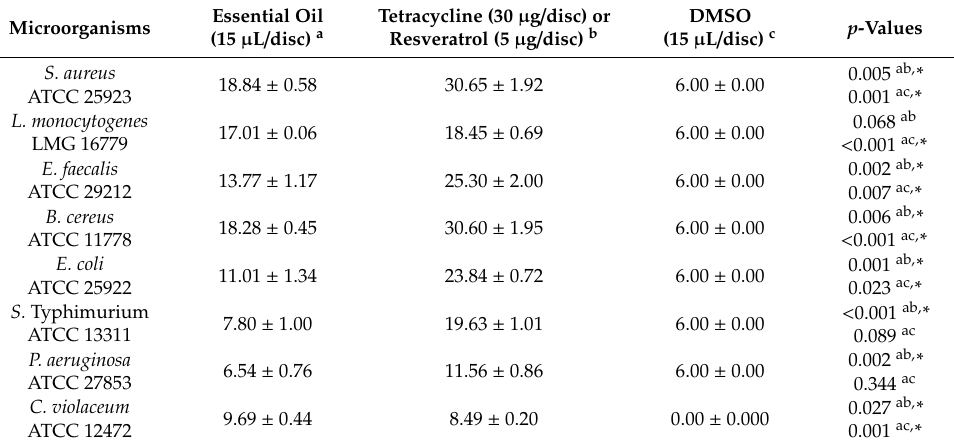
Table 3. Diameters of inhibition zones and of inhibition of the violacein production (mm).